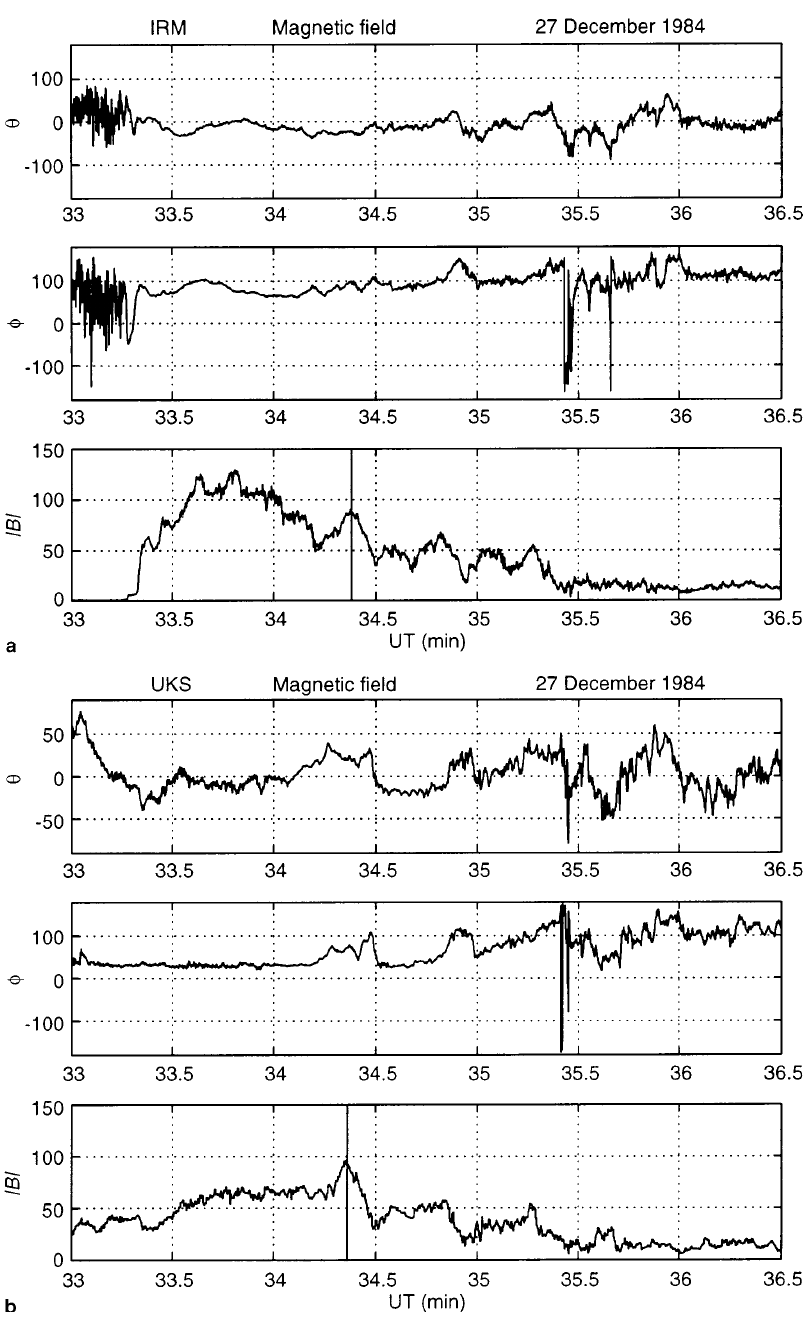
Fig. 8. Example of a curved discontinuity from the AMPTE-UKS/IRM solar wind bar- ium release, as discussed in